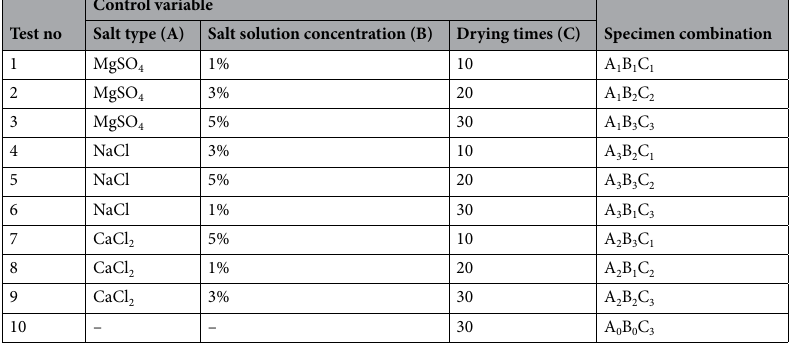
Table 2. Orthogonal